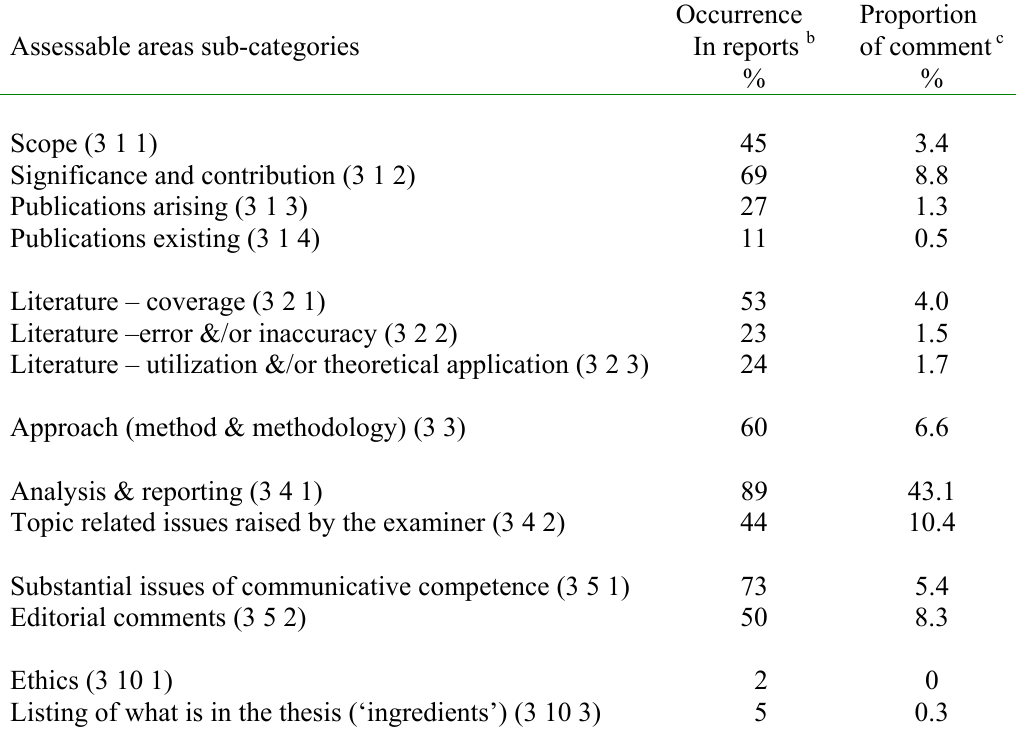
Table 1 : Assessable areas covered – occurrence of comment and proportion of total report